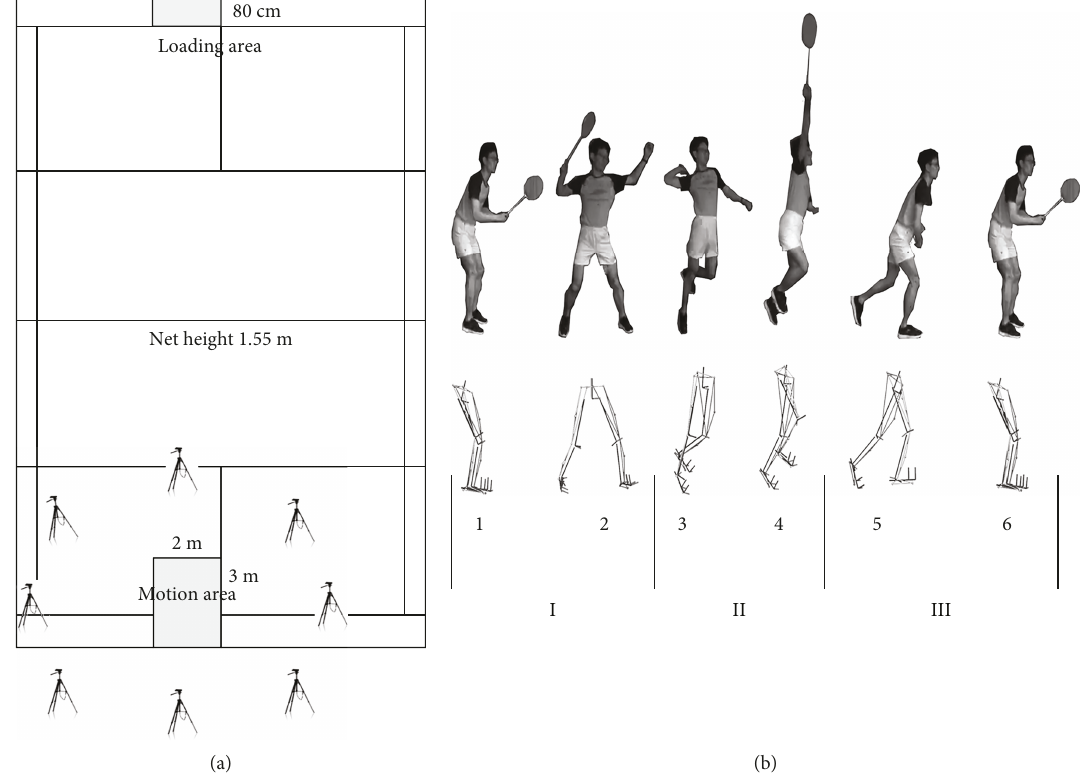
Figure 1: (a) A simulated badminton court in our laboratory including the eight camera positions, motion area, and shuttle loading area. (b) The detailed action diagram of the backcourt forehand clear stroke; the upper image shows one elite participant ’ s whole body and racket movement; the lower image shows the simulation of his lower limb movement in the Vicon